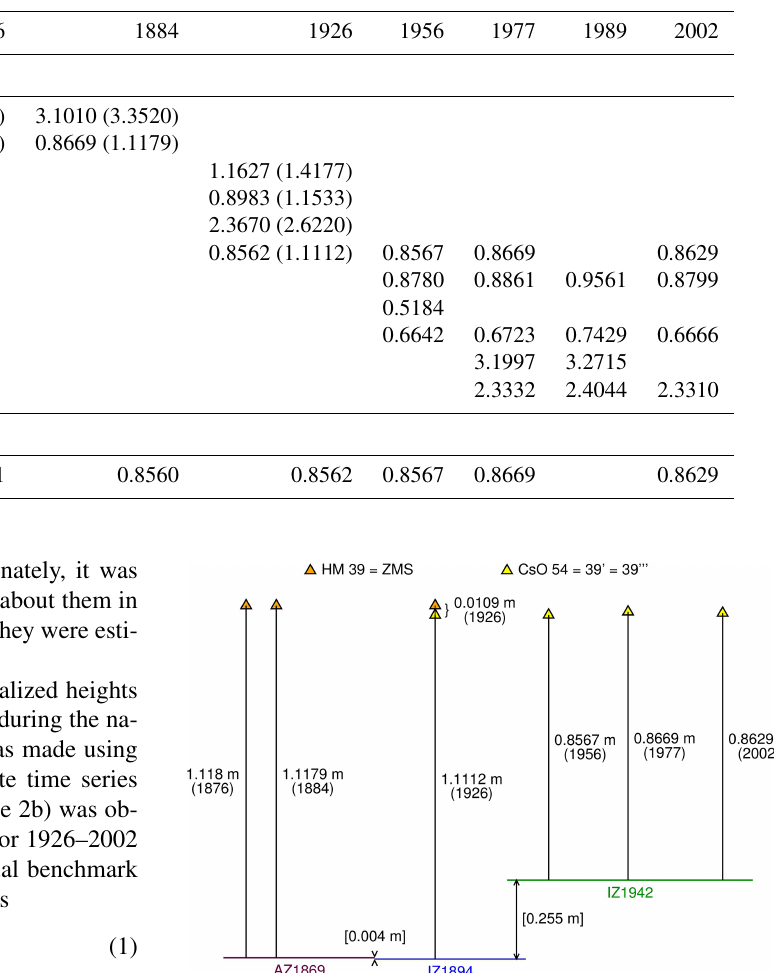
Table 2. (a) Heights (m) of the benchmarks near the tide gauge at Molo Sartorio relative to IZ1942. The measurements in the original reference system, namely AZ1869 for 1876 and 1884 and IZ1894 for 1926, are reported in parentheses. (b) Composite time series of heights (m) of VZMS = ZMS − 0.0109m and CsO 54/39 (cid:48) /39 (cid:48)(cid:48)(cid:48) relative to IZ1942. TG BM is the tide-gauge benchmark, and TG CP is the tide-gauge contact point. See the text for other details on denominations and normalizations.